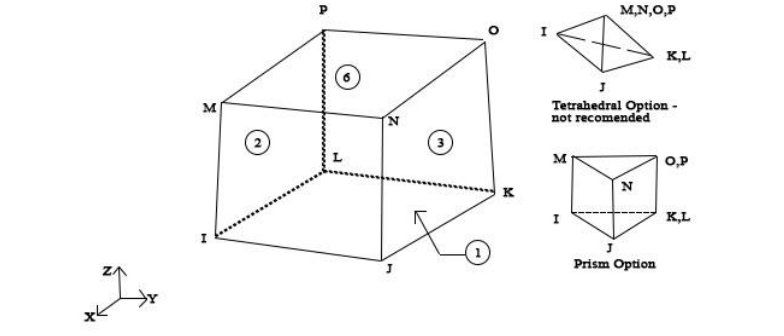
Fig. 3. SOLID 185 element.